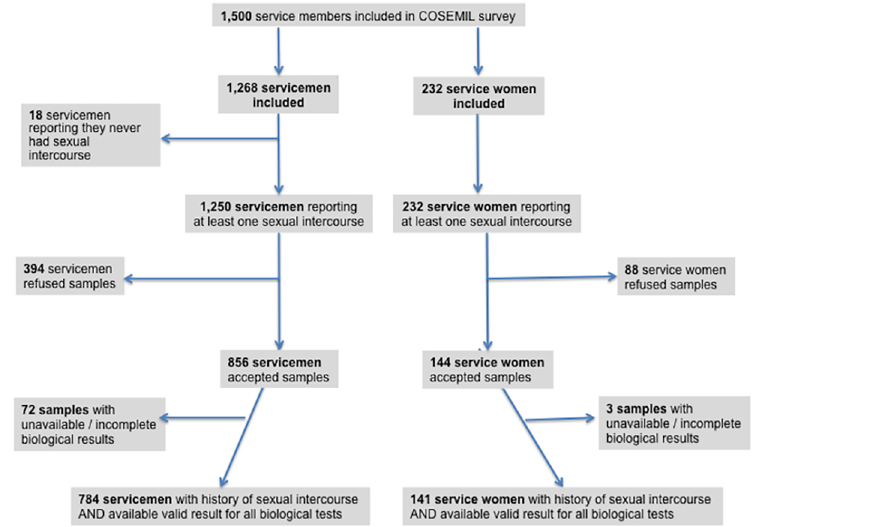
Fig 1. Flow chart for the analyses on lower STIs, COSEMIL